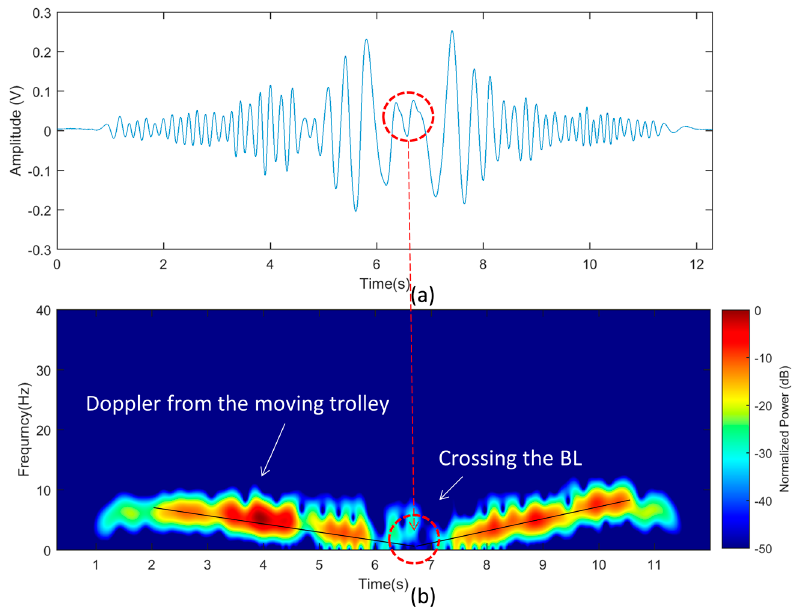
Figure 14. Experimental results of the moving trolley: ( a ) time domain Doppler signature; and ( b ) spectrogram.